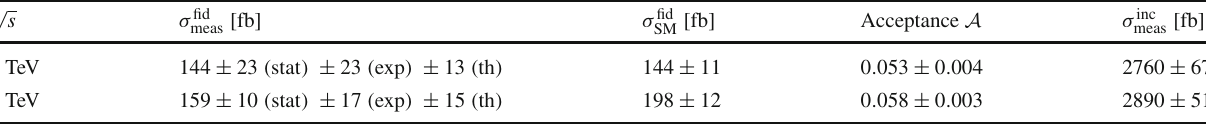
Table 6 Measured fiducial cross sections of electroweak W jj production in a single lepton channel, compared to predictions from Powheg + Pythia8 . The acceptances and the inclusive measured production cross sections with p √ s σ fid meas [fb] σ fid